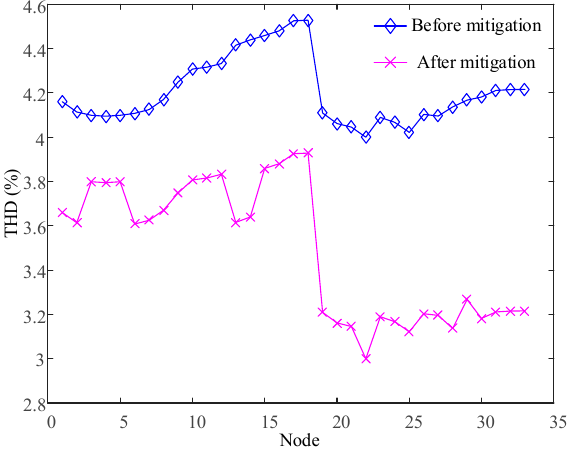
Figure 7. THD of each node at 7:00.